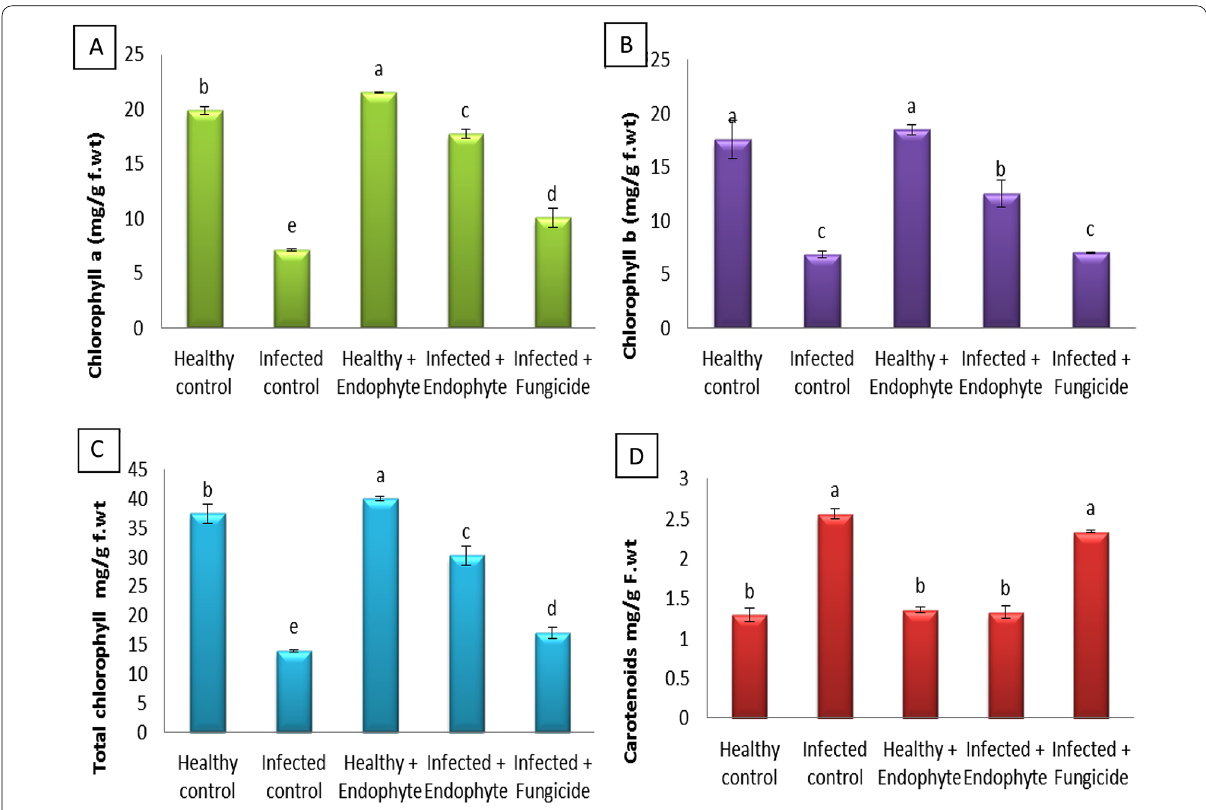
Fig. 4 Effect of A . terreus on A chlorophyll a , B chlorophyll b , C total chlorophylls and D carotenoids of S. melongena